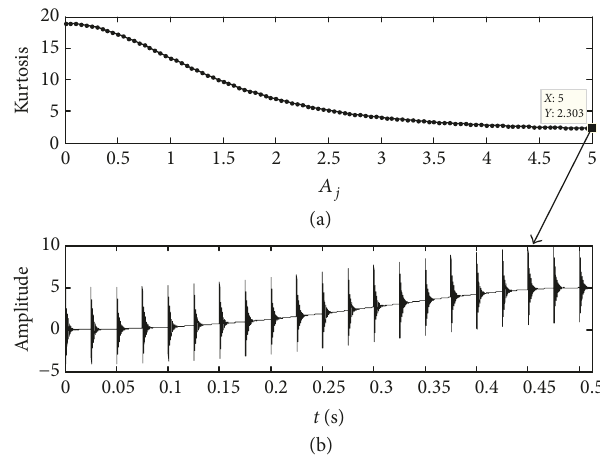
to get the amplitude of components from spectrum of